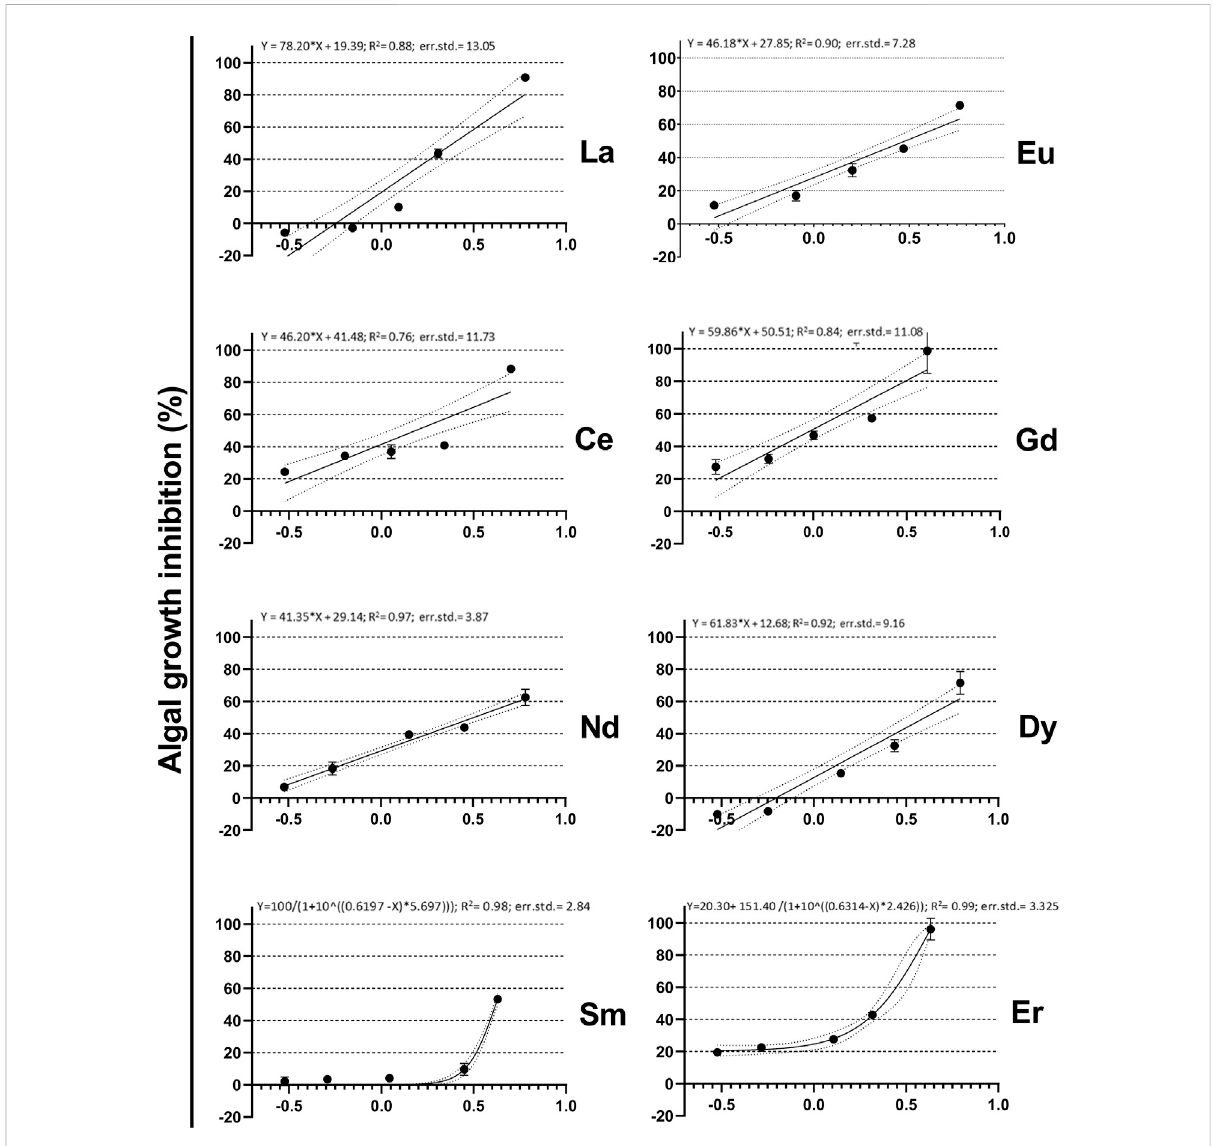
FIGURE 1 Concentration-response relationship of La, Eu, Ce, Gd, Nd, Dy, Sm, and Er exposed to P. tricornutum ; x-axis log scaled concentrations are in mg/L. Solid line indicates the line of best fi t, the dashed lines represent the 95% con fi dence intervals for linear regression (La, Eu, Ce, Gd, Nd, and Dy) and for nonlinear regression (Sm, and